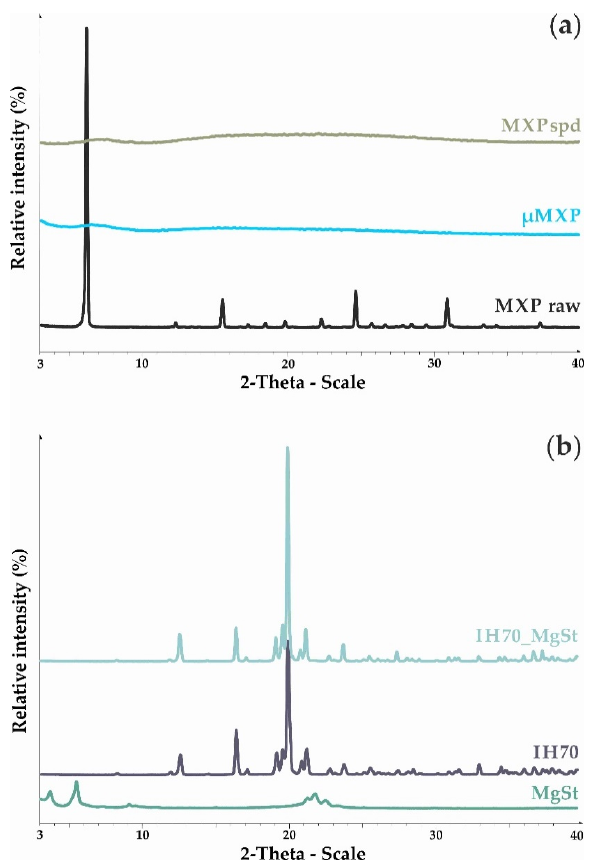
Figure 2. XRPD patterns of raw MXP, the carrier-free drug formulations ( a ), and the excipients ( b ).